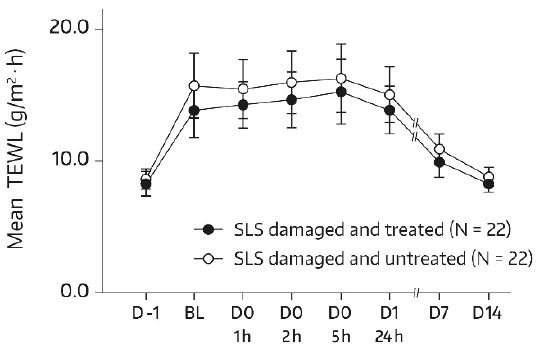
Figure 5. Results from the TEWL measurements (forearm) in untreated SLS-damaged skin and SLS-damaged skin undergoing a single application of the body wash gel (first 24 h) followed by once-daily applications for 13 days. The values are presented as mean ± SD. The SLS challenge started on day -1 and stopped 24 h later (30 min before the BL assessment). BL—baseline TEWL value before the first product application; D—day; h—hour; SLS—sodium lauryl sulfate.